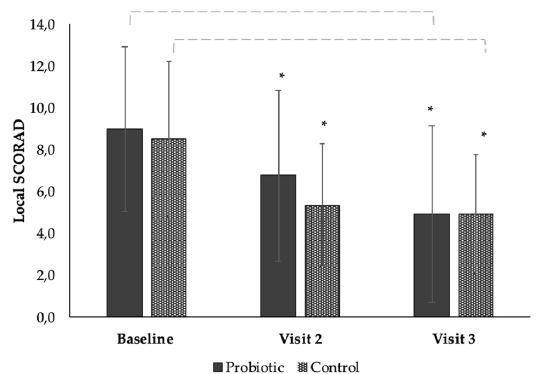
Figure 2. Bar chart showing the mean reduction in Local SCORAD of the subjects after continuous use of the probiotic or control product at baseline, visit 2 (day 28), and end of study visit (day 56). Each error bar is constructed using one standard deviation from the mean. * ; significance value of p = 0.001.